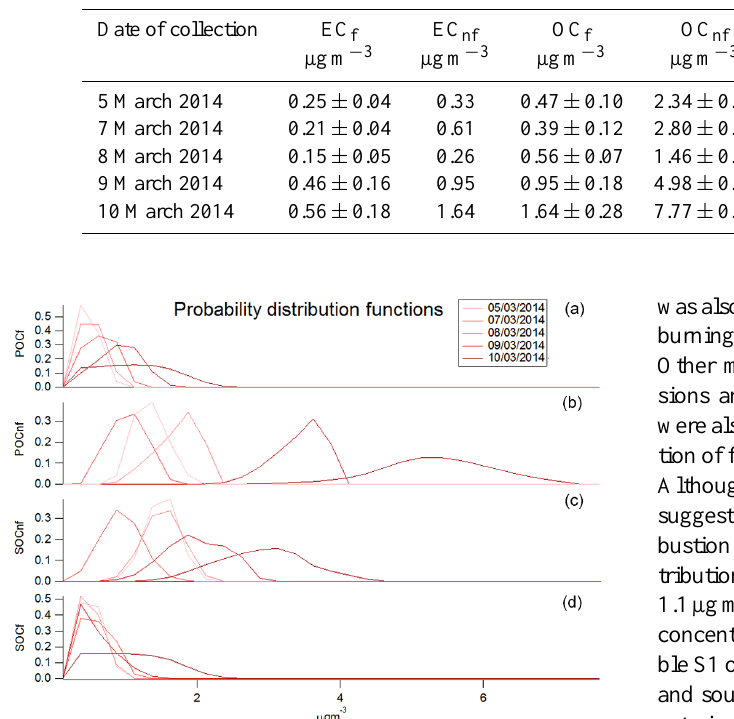
Figure 6. Mass spectra of SOA and POA, error bars represent the standard deviation of 20 PMF runs (a, c) and the scatter plots illustrate the relationship between SOA and NH + (b) and POA with BC (d) . 4 Table 2. Variation of the fractions of EC f , EC nf , OC f , OC nf and TC, EC and OC values during the study periods.